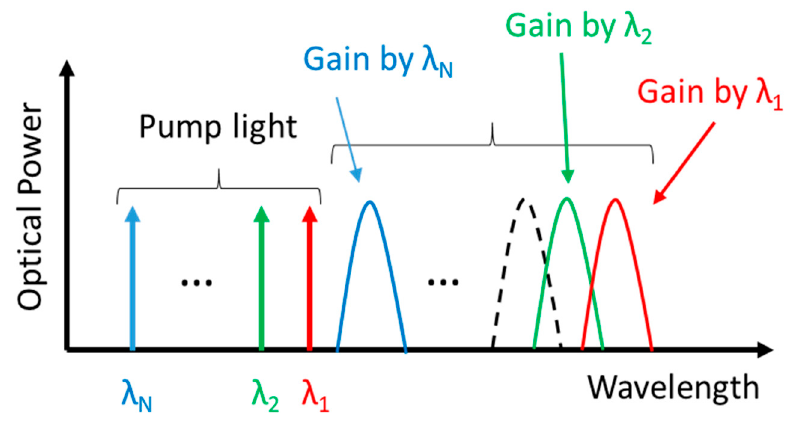
Figure 6. Multi-wavelength pumping technique for wideband Raman Figure 6 . Multi-wavelength pumping technique for wideband Raman amplifiers.